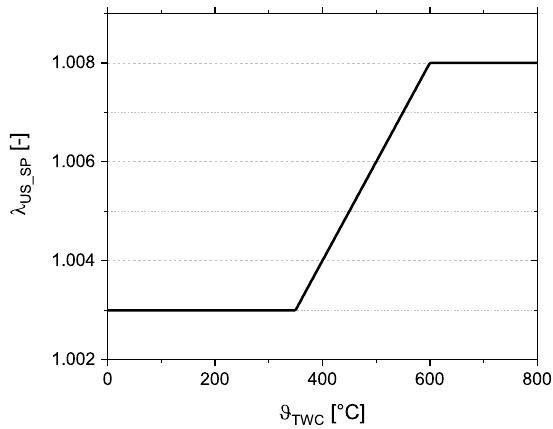
Figure 6. Trajectory for λ US _ SP based on the temperature of the TWC ϑ TWC